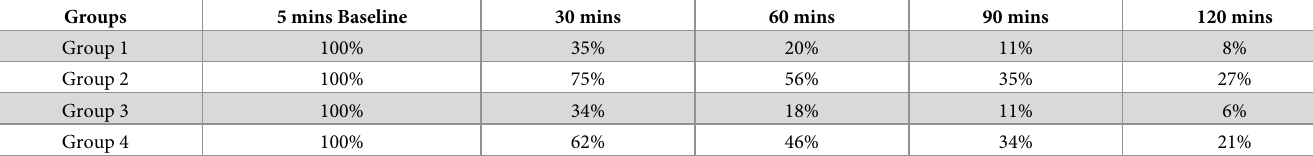
Table 2. Percent values of small particle counts detected at different time points from 5 mins baseline. Groups